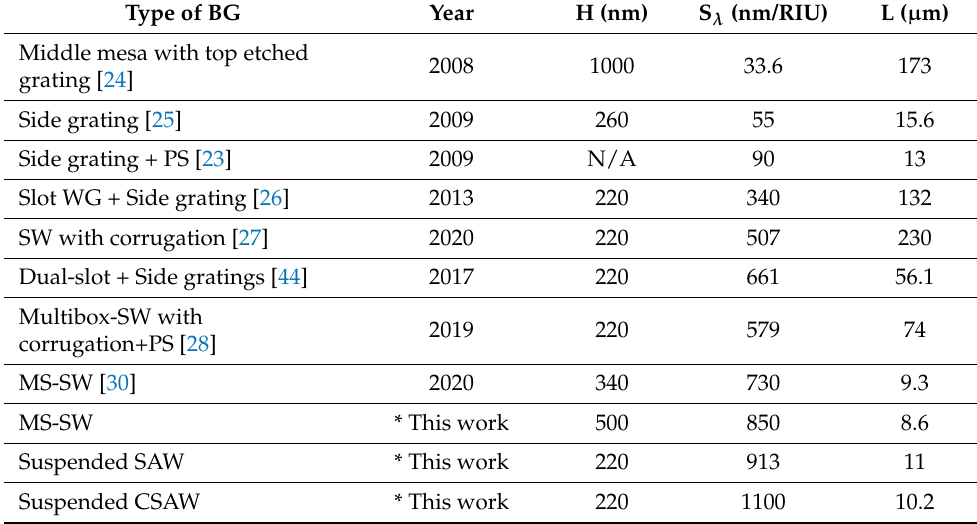
Table 1. Various BG RI sensors on SOI